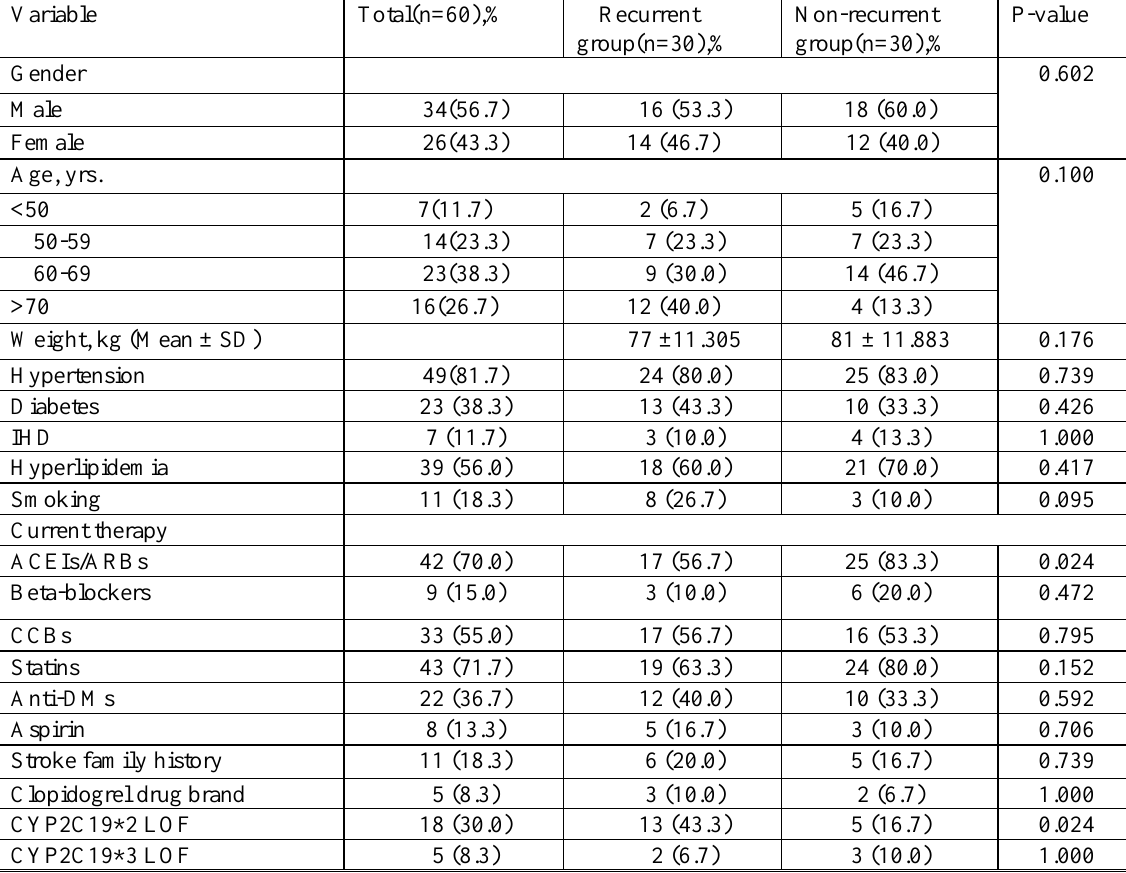
Table Error! No text of specified style in document. 1. Demographic and clinical characteristics of the study sample